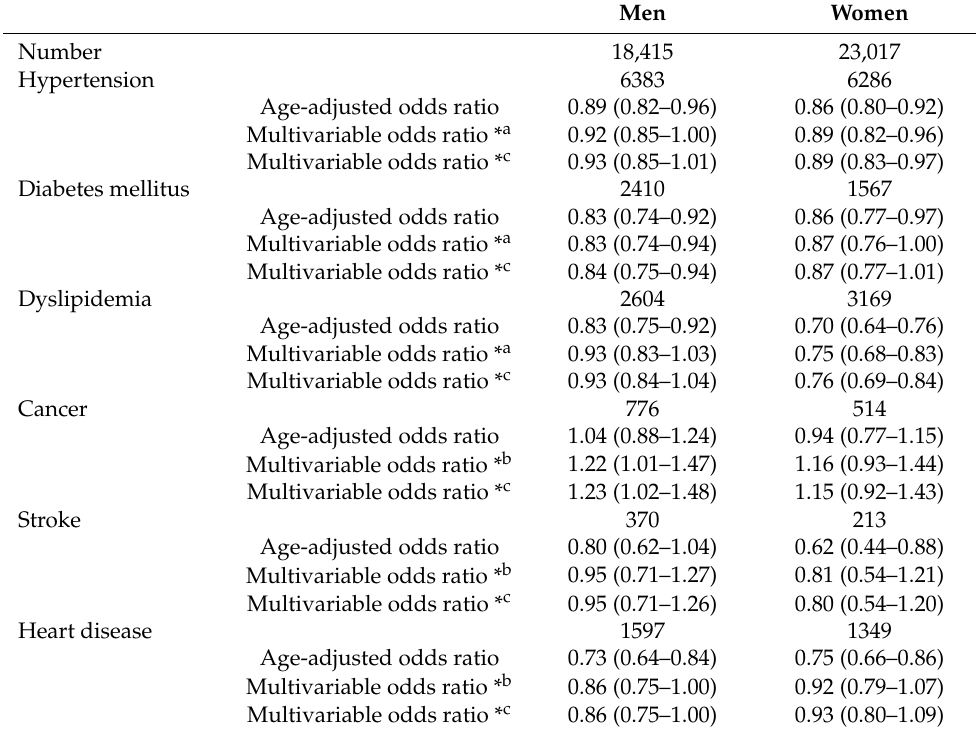
Table 2. Gender-specific age-adjusted and multivariable odds ratios of lifestyle diseases for those who laugh every day compared to those who do not laugh every day.